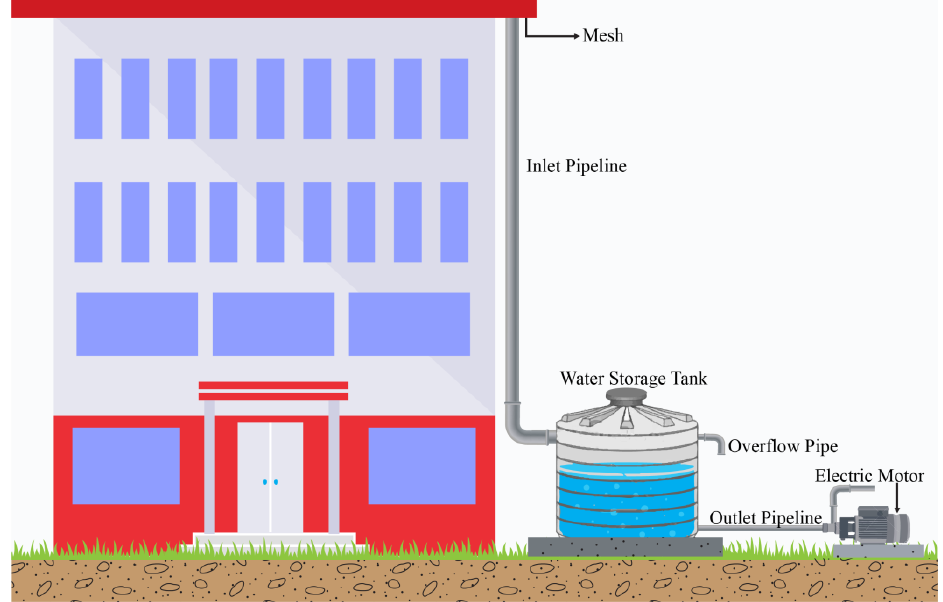
Figure 3. Schematic diagram of a rooftop harvesting system.